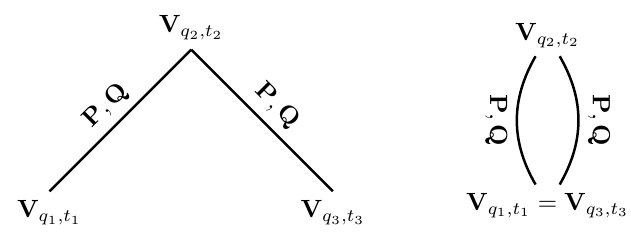
Figure 4 . Gluing three q -Virasoro algebras would fail the commutativity requirement, unless the third algebra is identified with the first, as shown on the